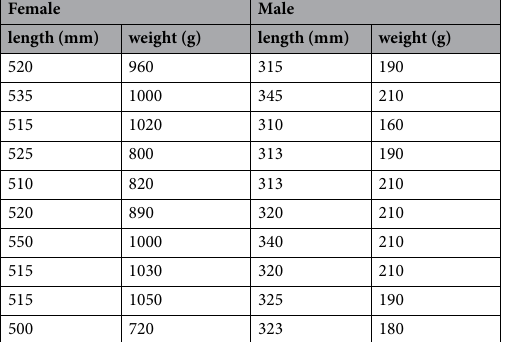
Table 1. The lengths of females were averagely 202 mm longer than males, and the weights of females were aver- agely 733 g heavier than males, which reflect the obvious sexually dimorphic growth with the females growing much faster than males. The fish were kept at 25 °C in aerated seawater for a week before using. Blood drawn from 10 tails of male and female fishes respectively was collected. For exosome isolation, the blood from ten male fishes was merged, and so did the female fishes. Exosomes in blood were isolated with differential centrifugation (Fig. 8). The isolated exosome pellet was resuspended in 1/10 of original volume using sterile water prepared for the following detection and analysis.